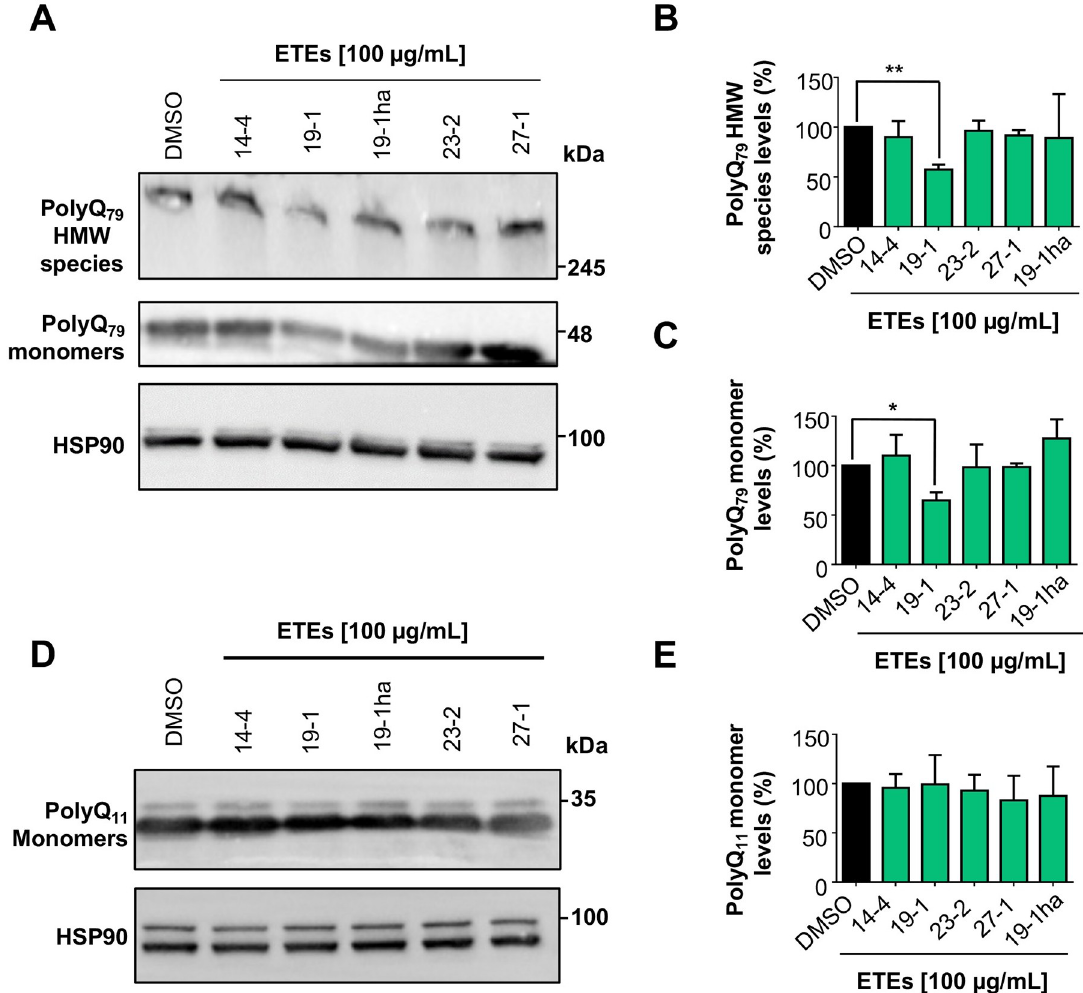
Fig 3. ETE of U . molinae fruits from the 19–1 genotype decreases the levels of polyQ 79 -EGFP in HEK293 cells. (A) The effect over polyQ 79 -EGFP levels was analyzed by western blot. Cells were transfected with the polyQ 79 -EGFP and 4 h post-transfection, cells were treated with the SEs at a 100 µ g/mL concentration. After 16 h, cells were collected, and total proteins extracted. PolyQ 79 -EGFP monomer and HMW species levels were analyzed using an anti-GFP antibody. HSP90 expression was monitored as loading control. (B) PolyQ 79 - EGFP HMW species quantification. (C) PolyQ 79 -EGFP monomer quantification. (D) The effect over polyQ 11 -EGFP levels was analyzed by western blot as described before. PolyQ 11 -EGFP monomer levels were analyzed using an anti-GFP antibody. HSP90 expression was monitored as loading control. (E) PolyQ 11 -EGFP monomer quantification. Results are the mean ± SEM of 3 independent experiments. Statistically significant differences were detected by one-way ANOVA and Dunnett’s multiple comparisons test considering DMSO as control ( � = p < 0.05; �� = p < 0.01).